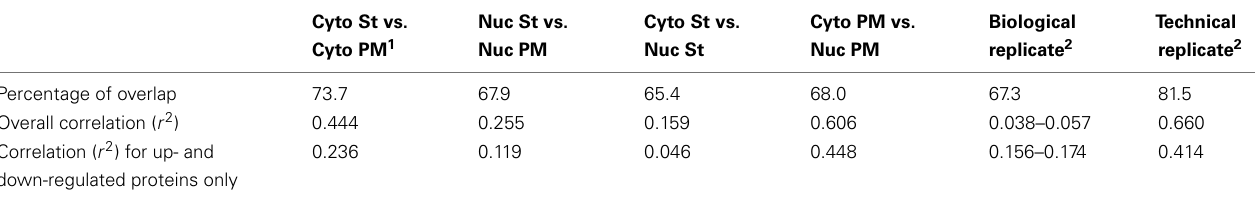
Table 3 | Correlation and overlap between various sample preparation schemes.